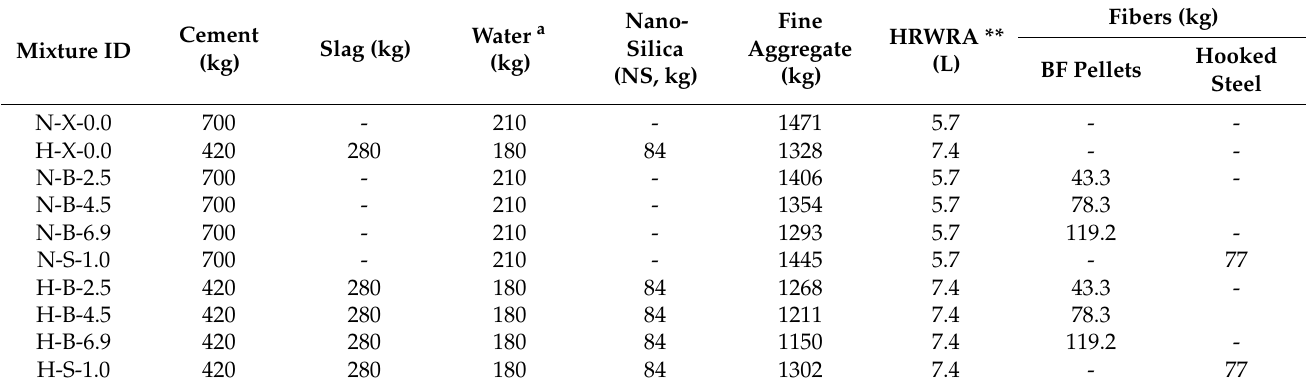
Table 3. Proportions of the mixtures per cubic